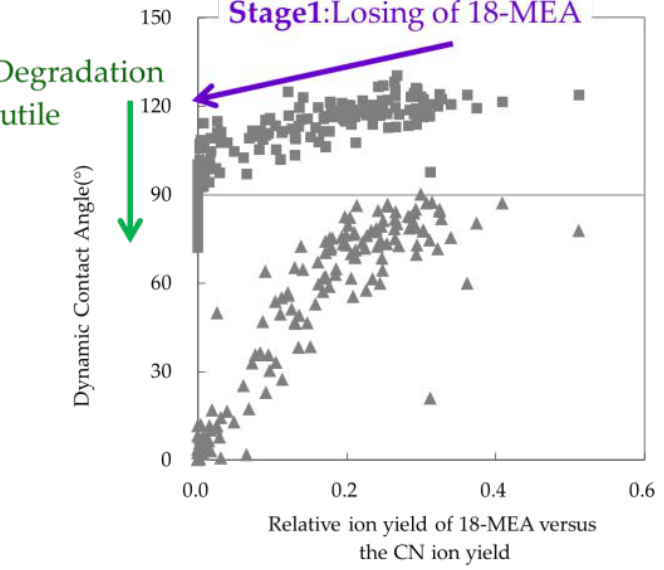
Figure 13. Explanation of two stages in hair surface degradation.